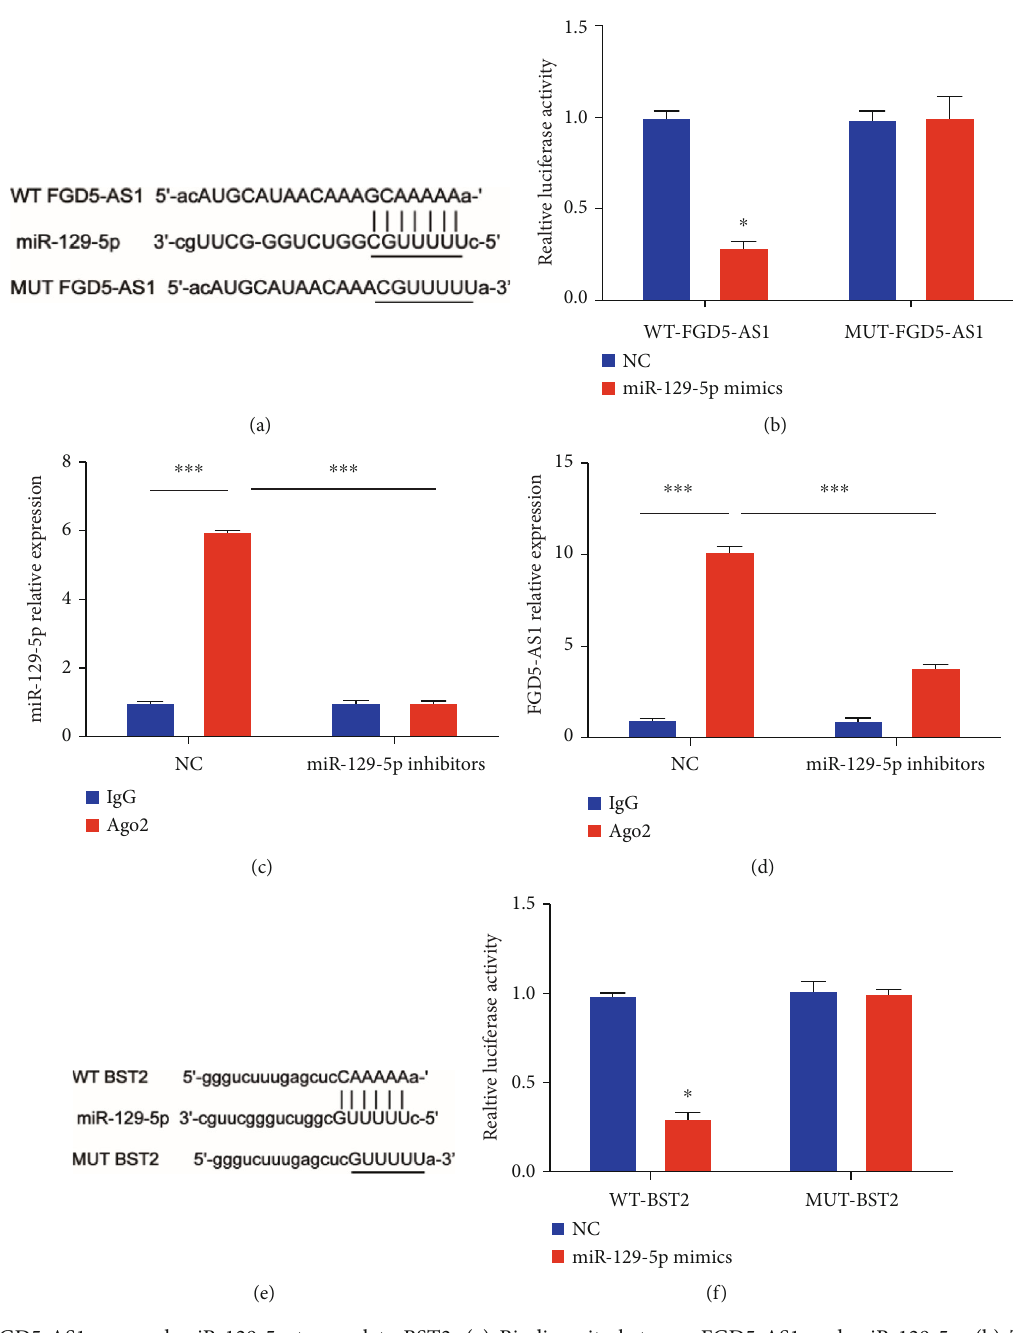
Figure 4: FGD5-AS1 sponged miR-129-5p to regulate BST2. (a) Binding site between FGD5-AS1 and miR-129-5p. (b) The luciferase activity in FGD5-AS1-WT and FGD5-AS1-MUT after transfection with miR-129-5p mimics or NC. (c, d) Enrichment of FGD5-AS1 and miR-129-5p in the anti-Ago2 or IgG immunoprecipitates in SiHa cells transfected with miR-129-5p NC or inhibitors. (e) The predicted binding site between BST2 and miR-129-5p. (f) The luciferase activity in BST2-WT and BST2-MUT after transfection with miR-129-5p mimics or NC. ∗ P < 0 : 05 . Three independent assays were carried